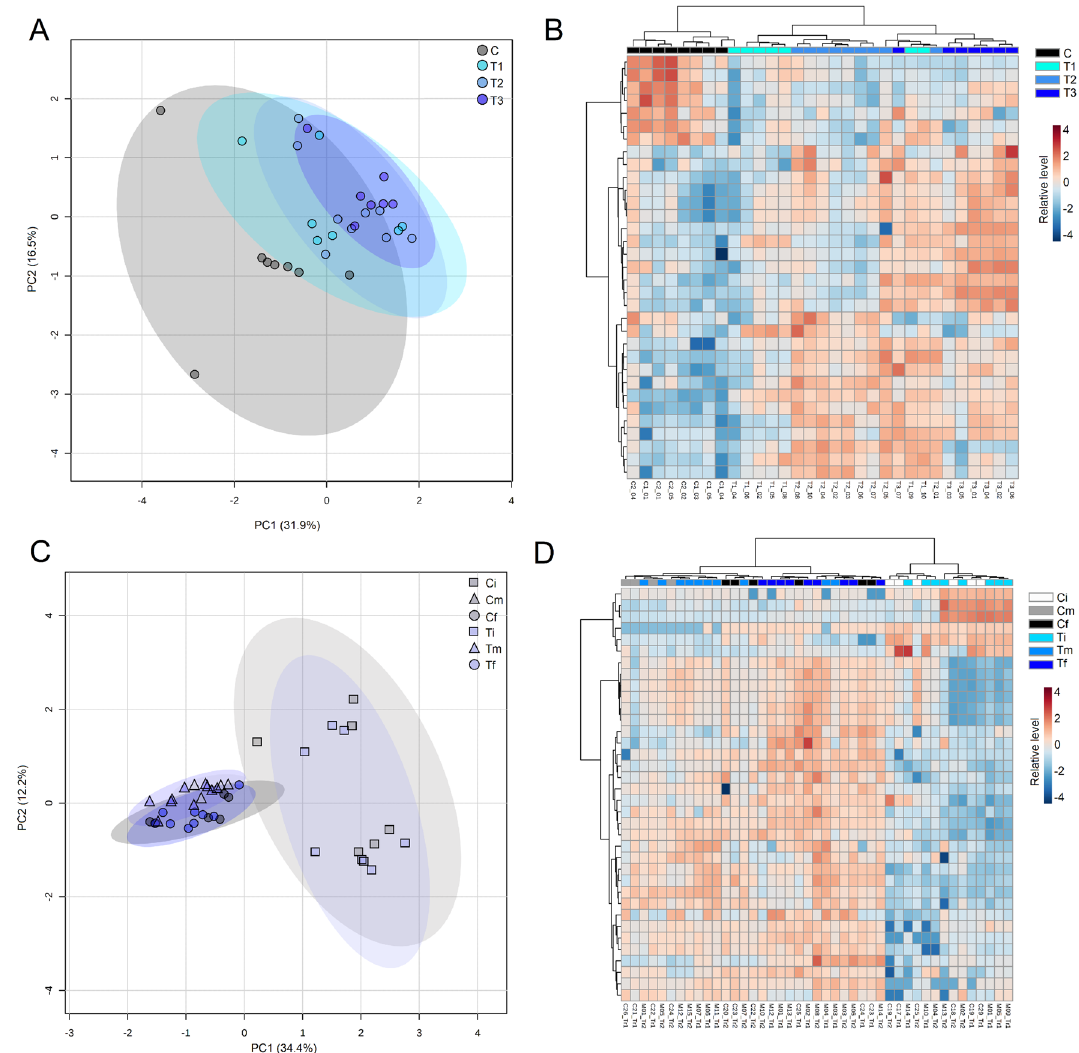
Figure 10. Metabolite profile of basil in Experiments 2 and 3. PCA scores plot of the entire metabolite dataset from ( A ) Experiment 2 and ( C ) Experiment 3. Heatmap with significant metabolites (ANOVA, FDR-adjusted p < 0.05 ) of ( B ) Experiment 2 ( n = 33) and ( D ) Experiment 3 ( n = 34). C: Control, T1: 4 weeks’ treatment, T2: 3 weeks’ treatment, T3: 2 weeks’ treatment (Experiment 2). Control and treated samples obtained at the first/ initial (Ci, Ti), second/intermediary (Cm, Tm), and third/final (Cf, Tf) sampling point (Experiment 3). Figure generated using the open source program Metaboanalyst 50